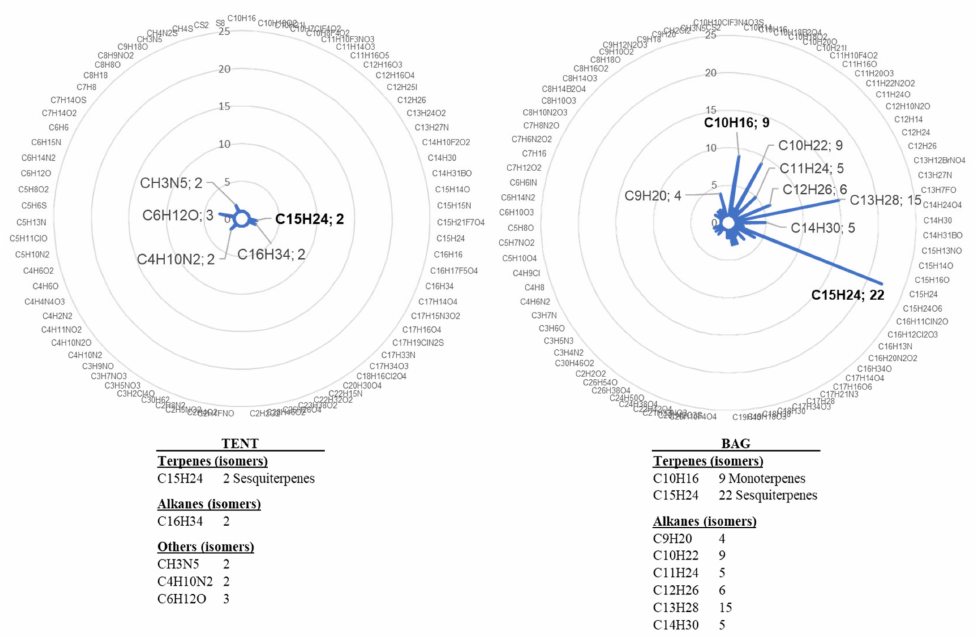
Figure 2. Chemical formulas detected in the bag or the tent containments. VOCs were collected for 4 h from four plants treated with water and individually enclosed in bags (bag) and from six plants gathered in a tent (tent). Radar plot illustrations correspond to the combined lists of VOCs detected on D3 and D5 after treatment. Chemical formulas were determined by GC-MS analysis and NIST